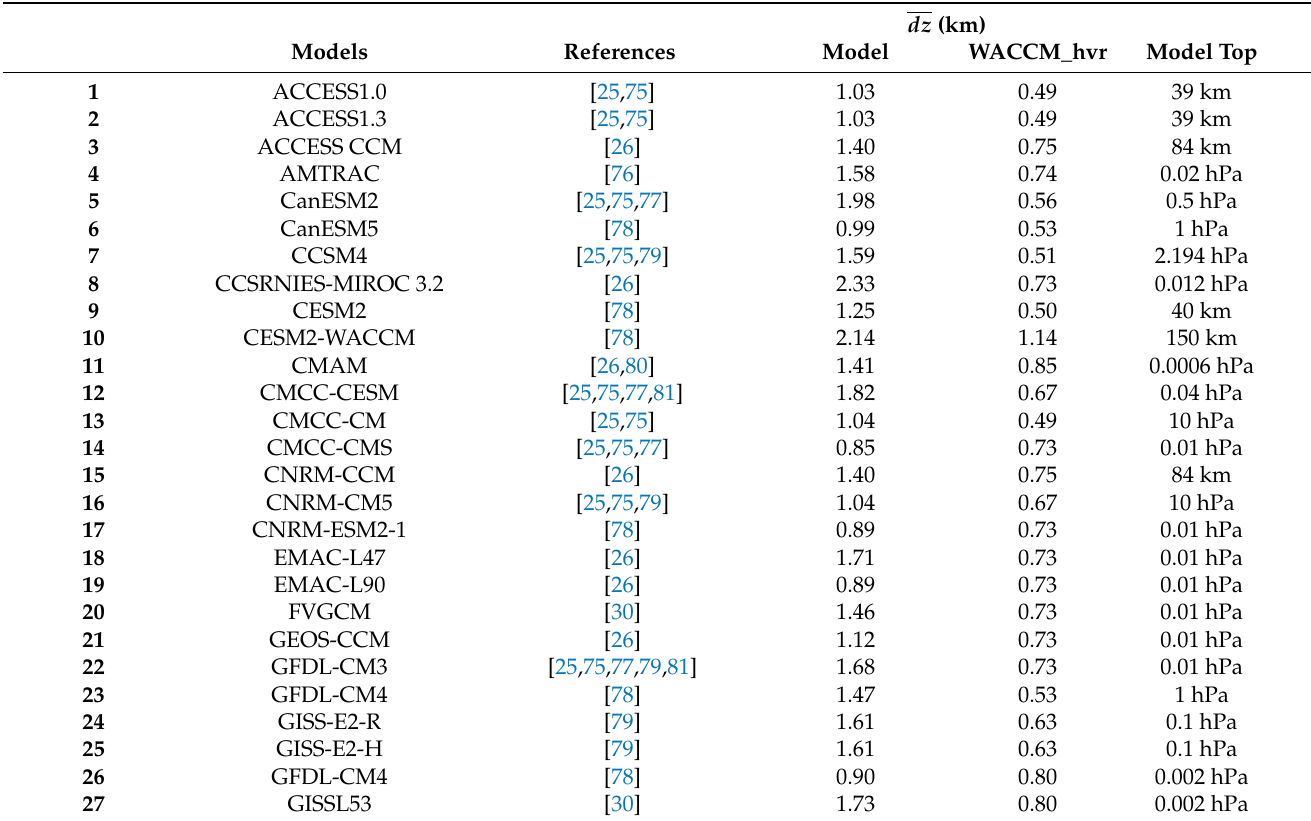
Table A1. Comparison between mean of the vertical resolution ( dz ) of the Models used for the study of the SSW during the period 2007–2020 and the Model WACCM with high vertical resolution (WACCM_hvr) for the same model